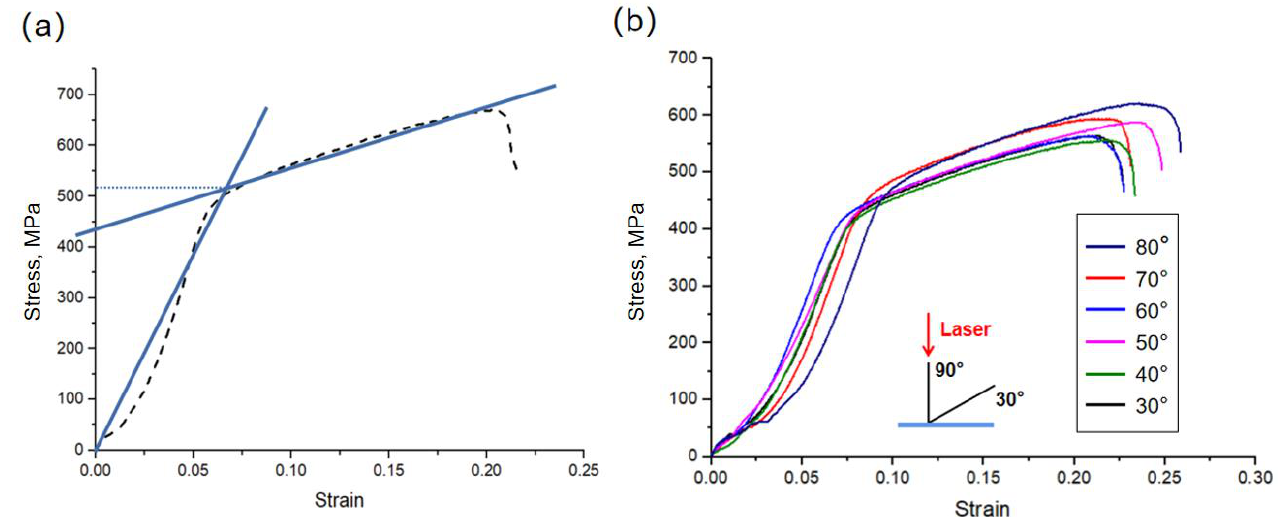
Figure 8. Uniaxial tensile test results of micro-rod: ( a ) 90 ◦ micro-rod and ( b ) micro-rod at inclination angles of 30 ◦ , 40 ◦ , 50 ◦ , 60 ◦ , 70 ◦ , and 80 ◦ .